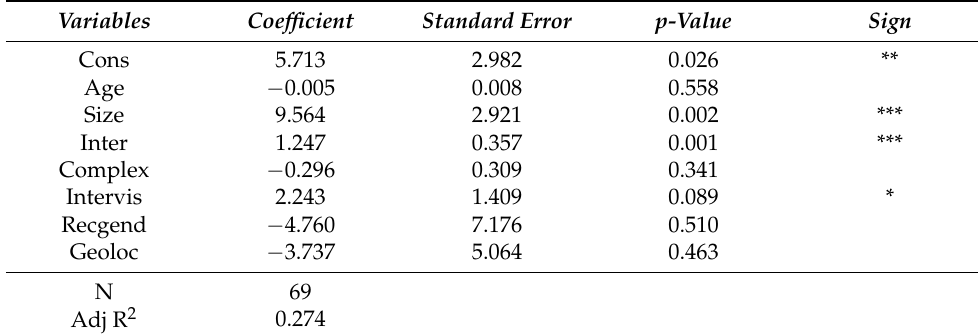
Table 4. Regression model